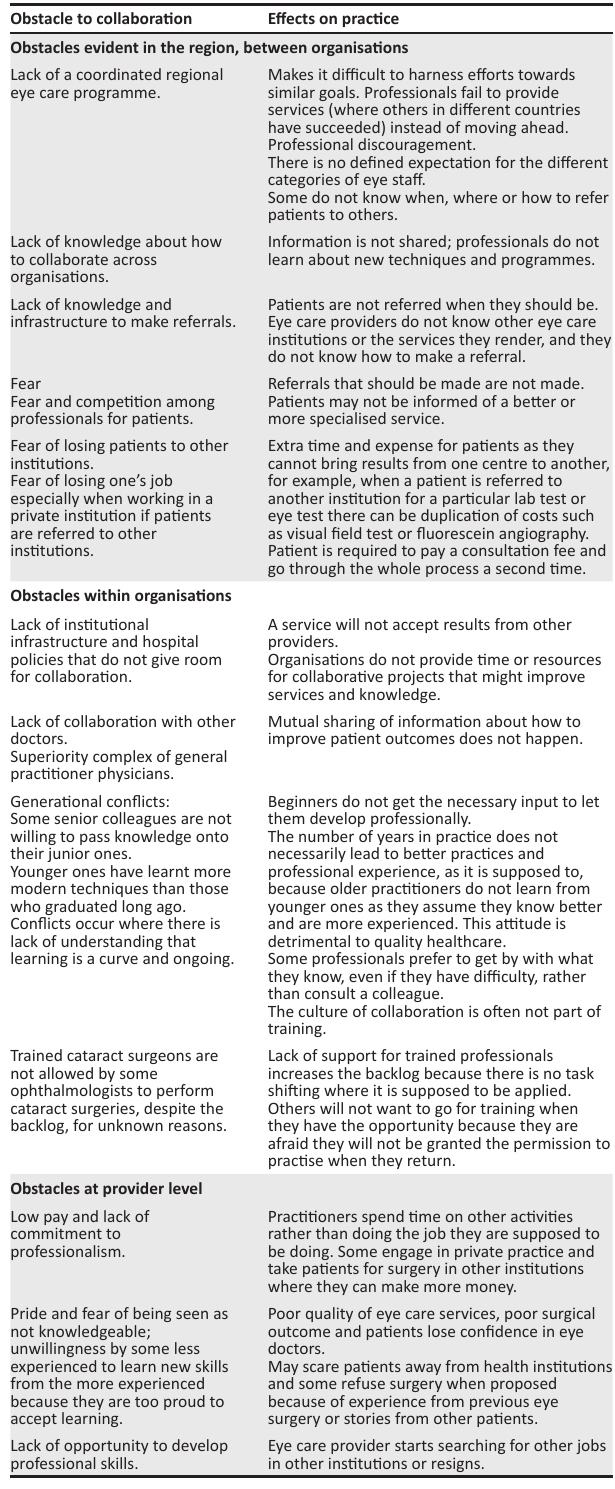
TABLE 1: Obstacles to collaboration. Obstacle to collaboration Effects on